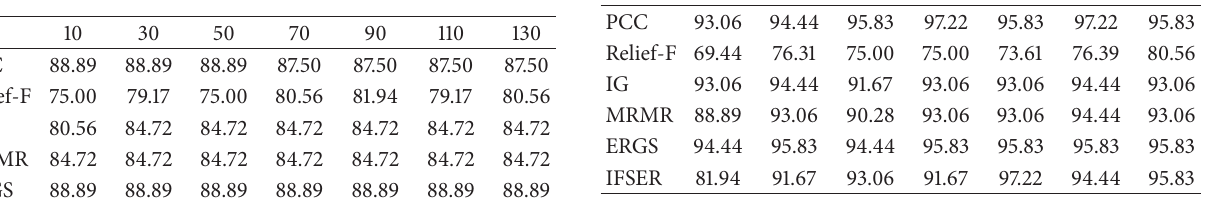
Table 2: Classification accuracies (%) of different feature selection methods with C4.5 on Leukemia1 database.